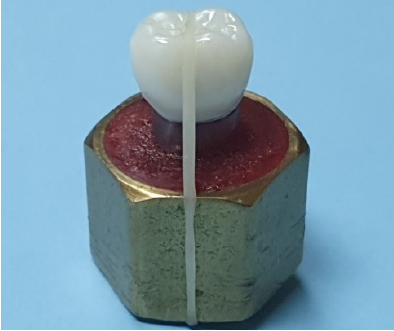
Figure 2. Elastic band holding the crown on the master metal die. Three different sagittal and coronal slices were selected both bucco-lingually (BL) and mesio-distally (MD), in addition to two slices that were chosen from the mesio-buccal (MB) to disto-lingual (DL) corner and disto-buccal (DB) to mesio-lingual (ML) corner, as shown in Figure 3.